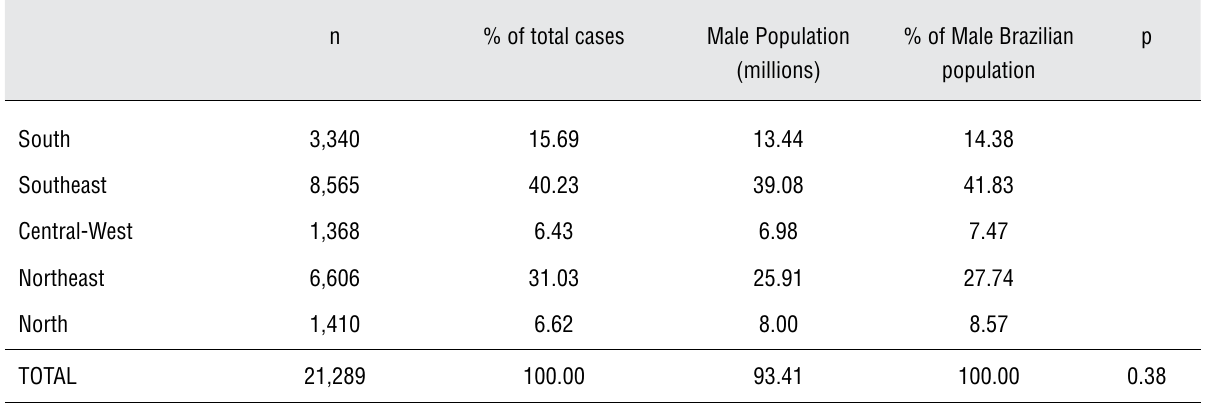
Table 1 - Distribution of men surgically treated for testicular torsion in each region of the country (1992-2010) and its male population (2010),